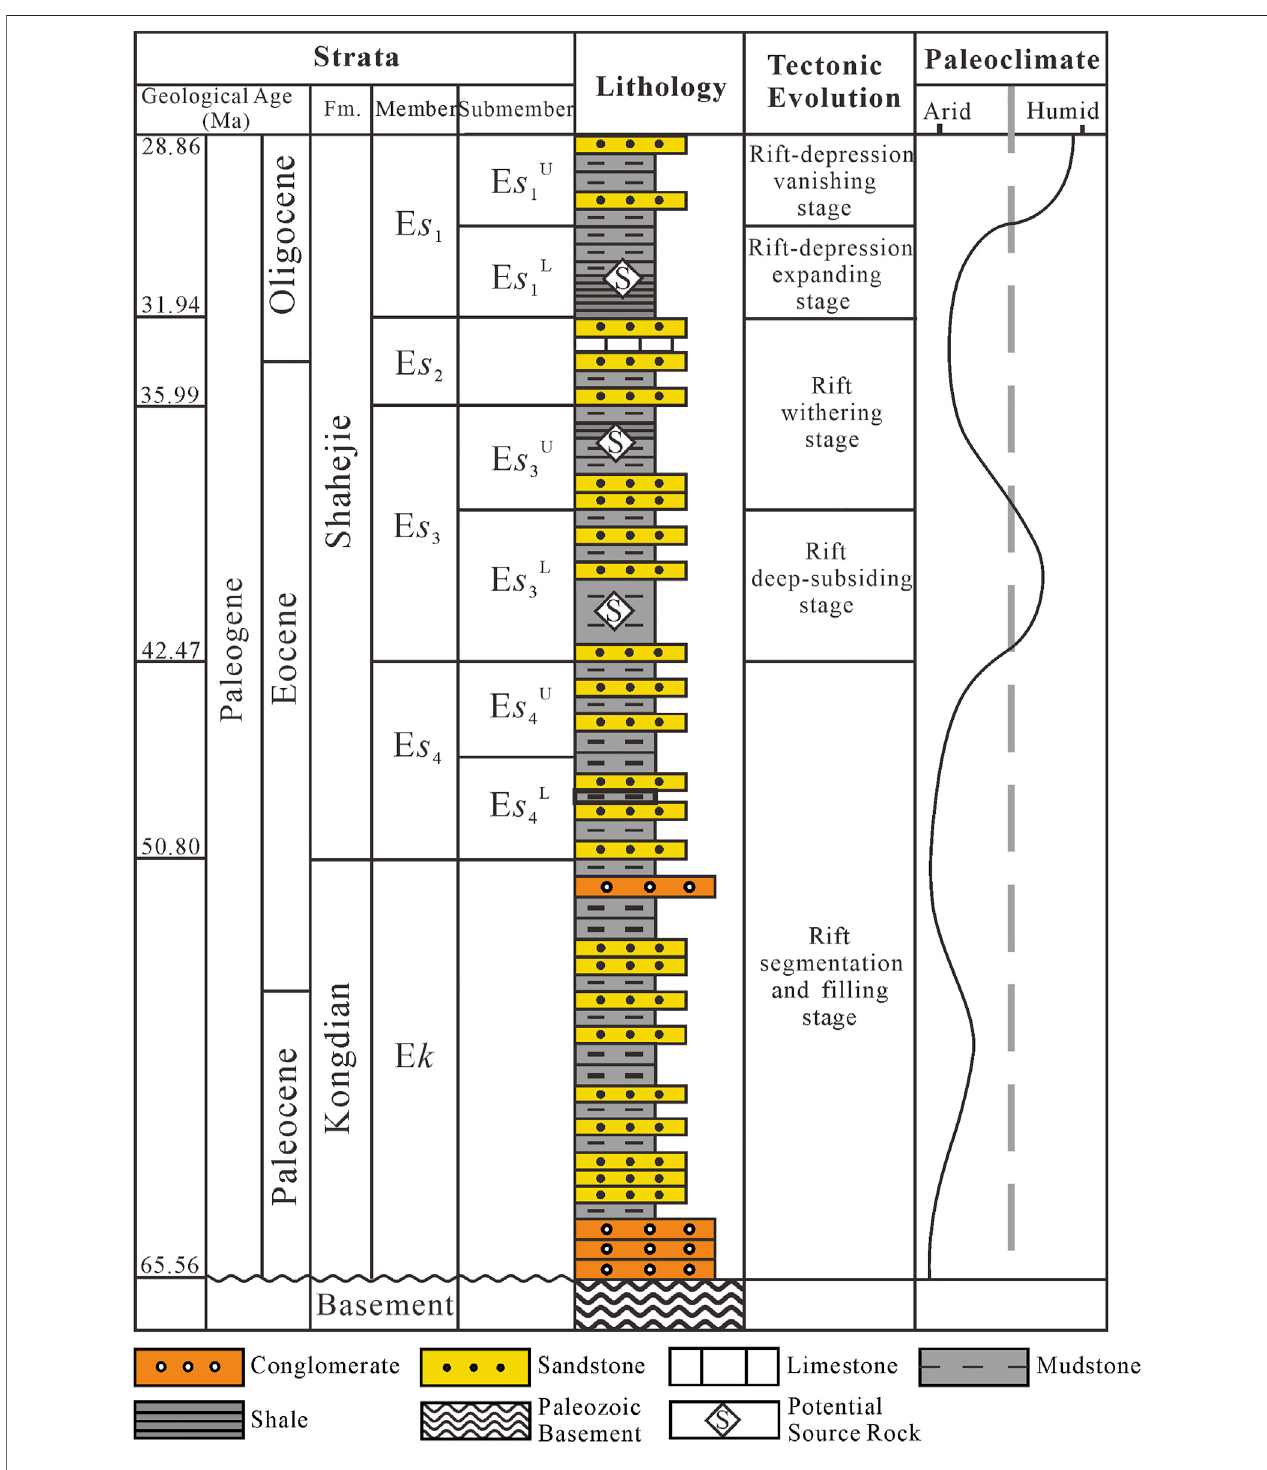
FIGURE 2 | Generalized stratigraphy of the Paleogene sequences in the Langgu Sag, Jizhong subbasin [modi fi ed after Cao et al. (2017)]. The cited ages and the palaeoclimate curve refer to Yin et al. (2018). Potential source rock intervals are marked. Fm, Formation; DY, Dongying; KD, Kongdian.